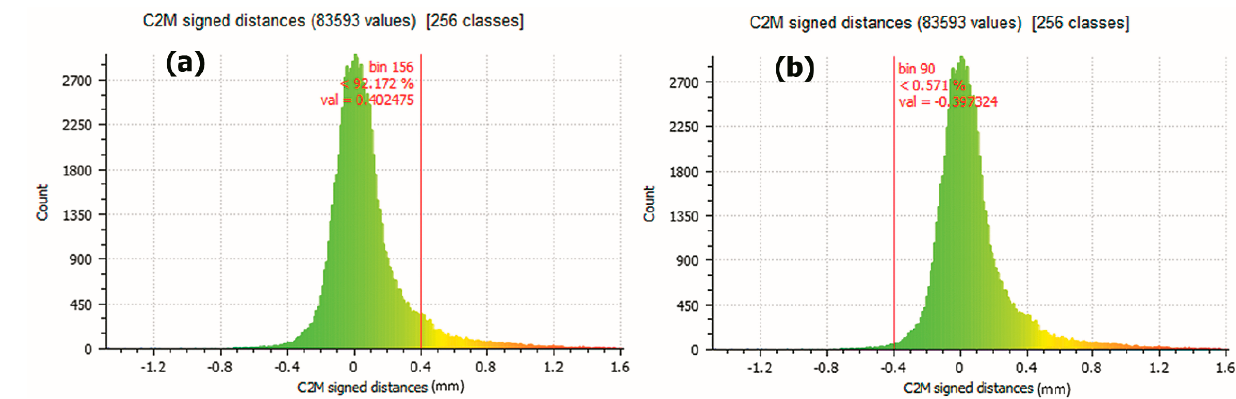
16 of 20 Figure 15. Charts for the Histogram and distribution generated by the Software Cloud Compare. (Source: self-made). Figure 16. ( a ) Results showing that 18.828% of the points have a larger difference than 0.2 mm. ( b ) Results showing that